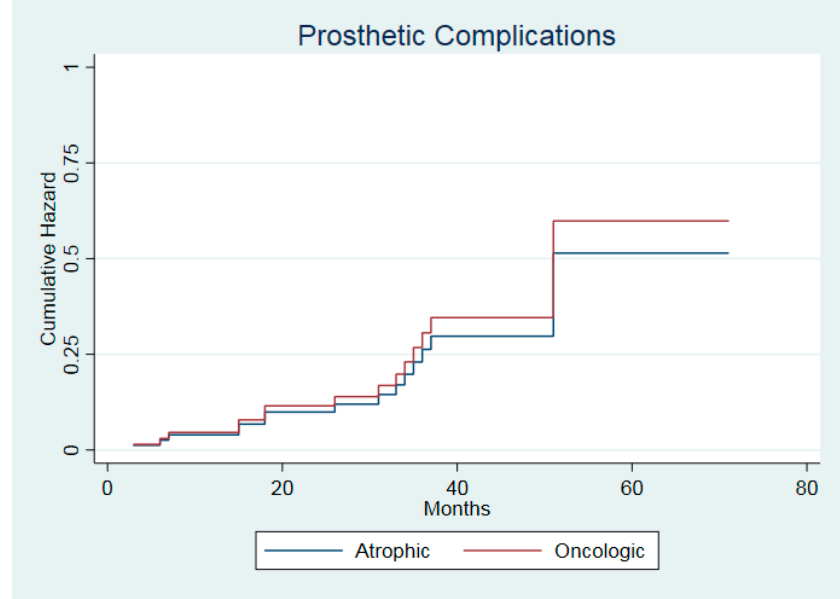
Figure 7. Hazard function of prosthetic complications in the two cohorts.